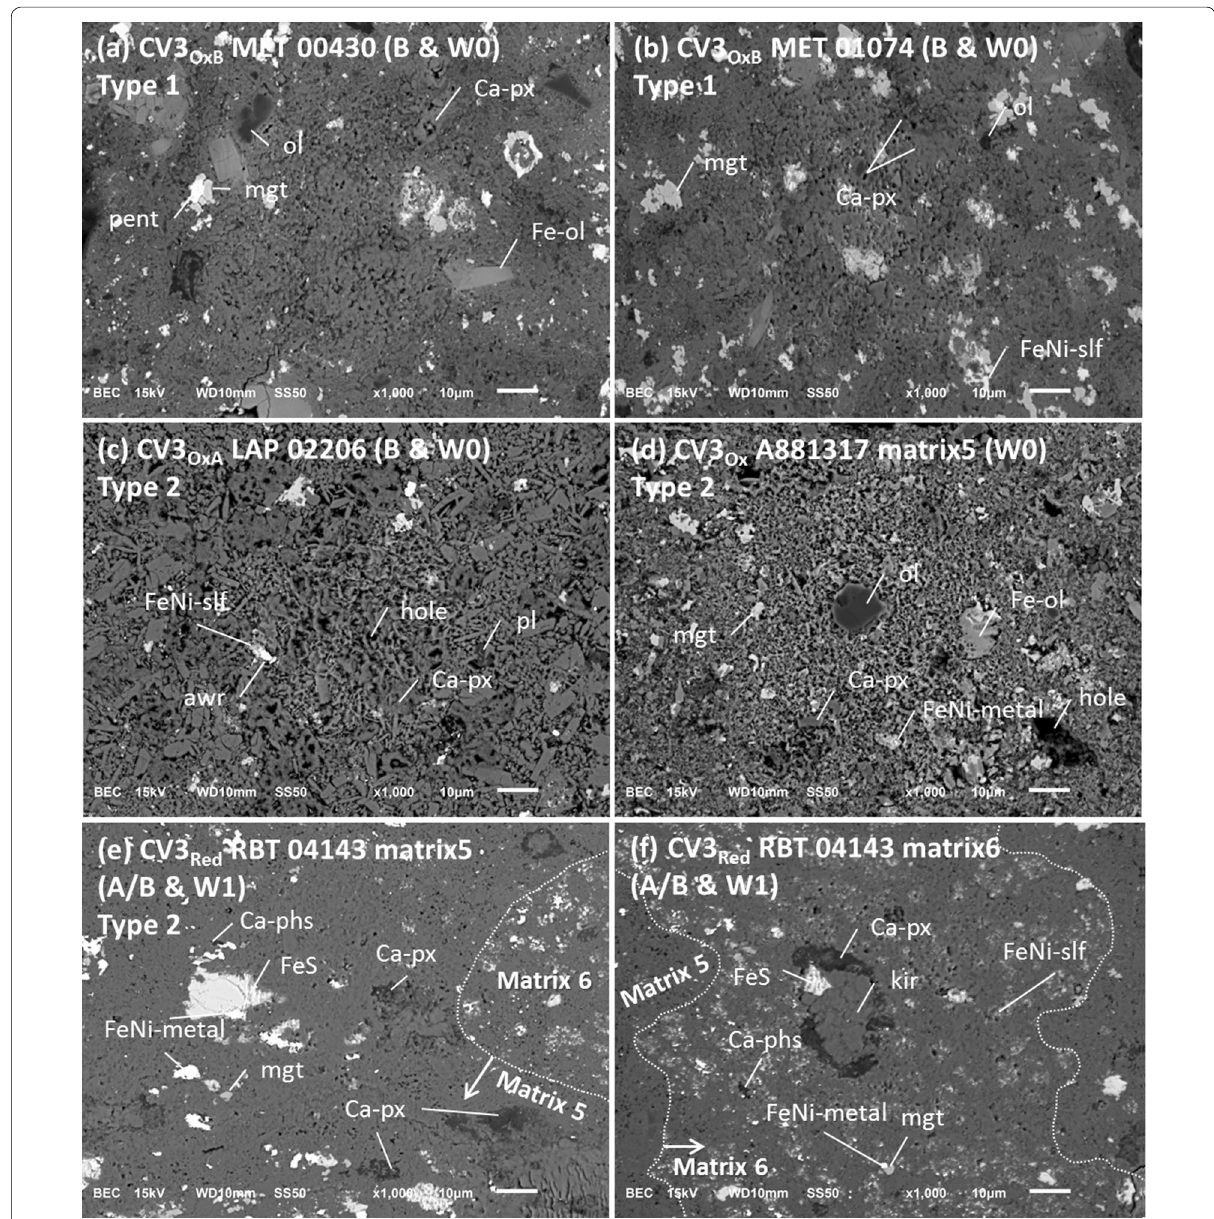
Fig. 1 Backscattered electron images of CV3 matrices: a CV3 OxB MET 00430 host matrix; b CV3 OxB MET 01074 host matrix; c CV3 OxA LAP 02206 host matrix; d CV3 Ox A 881317 matrix 5; e CV3 Red RBT 04143 matrix 5; f CV3 Red RBT 04143 matrix 6. Clast boundaries between CV3 Red RBT 04143 matrices 5 and 6 are shown by dotted lines in e and f . The weathering grade (A/B or B and W0 or W1) and matrix type (type 1 or 2) are also shown. All images are presented at the same magnification. awr awaruite, Ca - phs Ca-phosphate, Ca - px Ca-pyroxene, Fe - ol ferrous olivine, slf sulfide, kir kirschsteinite, mgt magnetite, ol olivine, pent pentlandite, pl